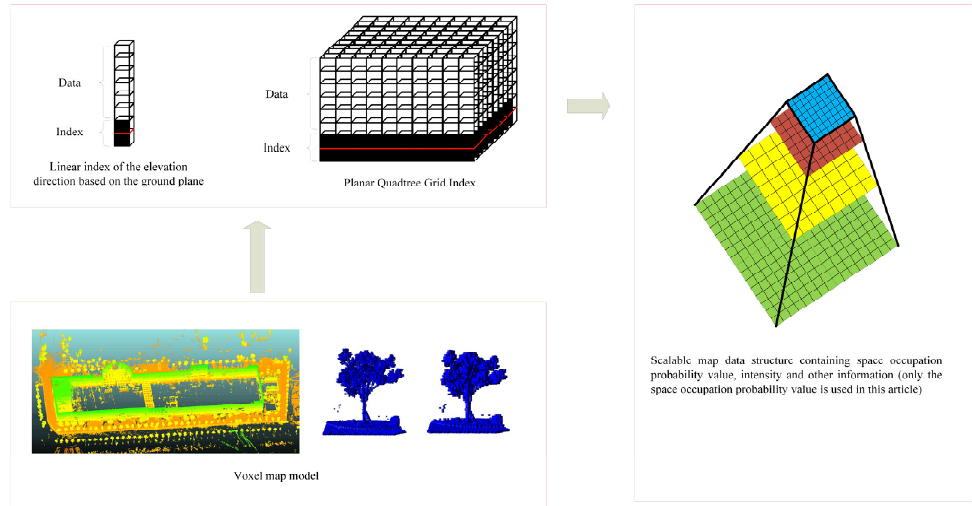
Figure 1. 3D EQT map model based on planar quadtree and elevation index.